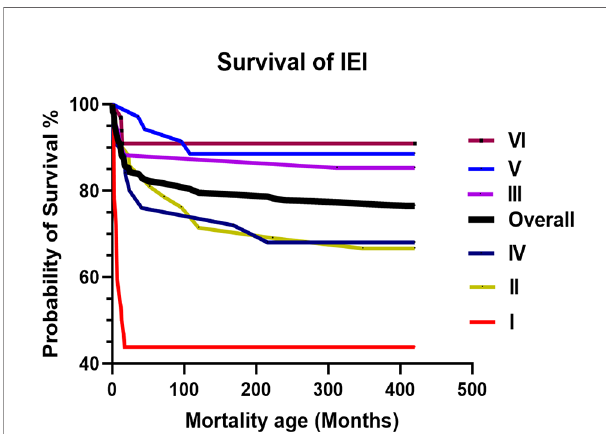
FIGURE 2 | The overall and IUIS class-speci fi c survival curve for Omani patients with IEI. Immunode fi ciencies affecting cellular and humoral immunity (I). Combined immunode fi ciencies (II). Predominantly antibody de fi ciencies (III). Diseases of immune dysregulation (IV). Congenital functional defects of phagocyte (V). Defects in intrinsic and innate immunity (VI). IEI, Inborn Errors of Immunity; IUIS, International Union of Immunological (18%) ( Table 3 ). As depicted by Costagliola et al. (25), failure to